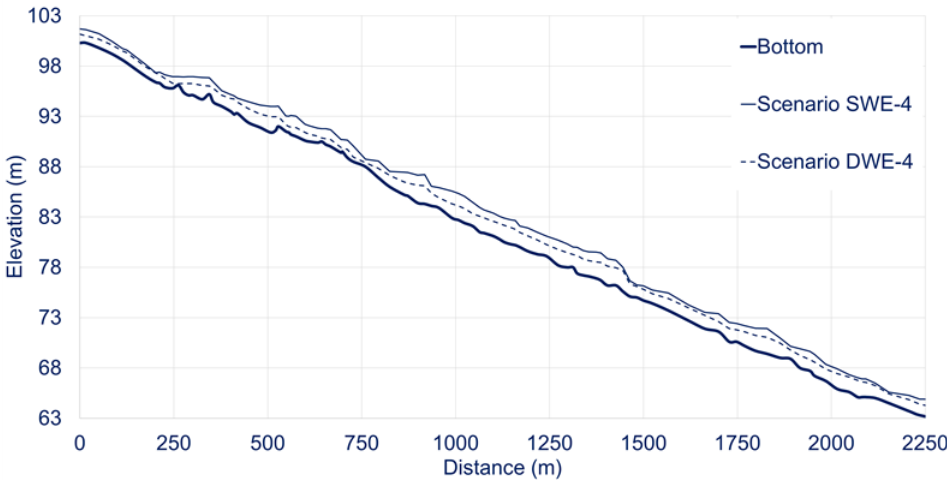
Figure 6. Comparison of water elevations along Koropouli Street for the scenarios SWE-4 and DWE-4.